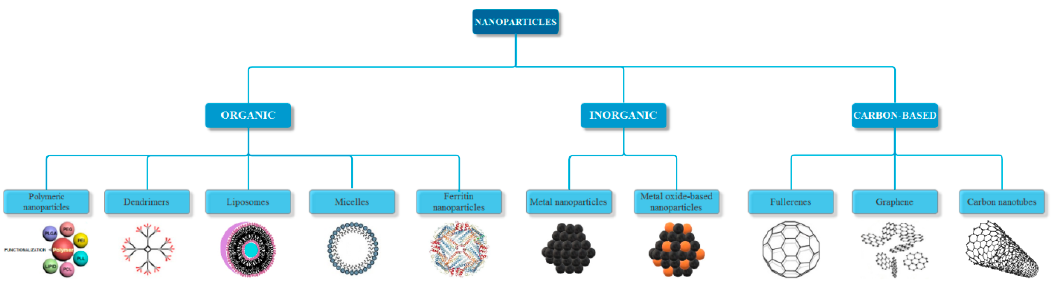
Figure 1. Classification of nanoparticles based on their nature.